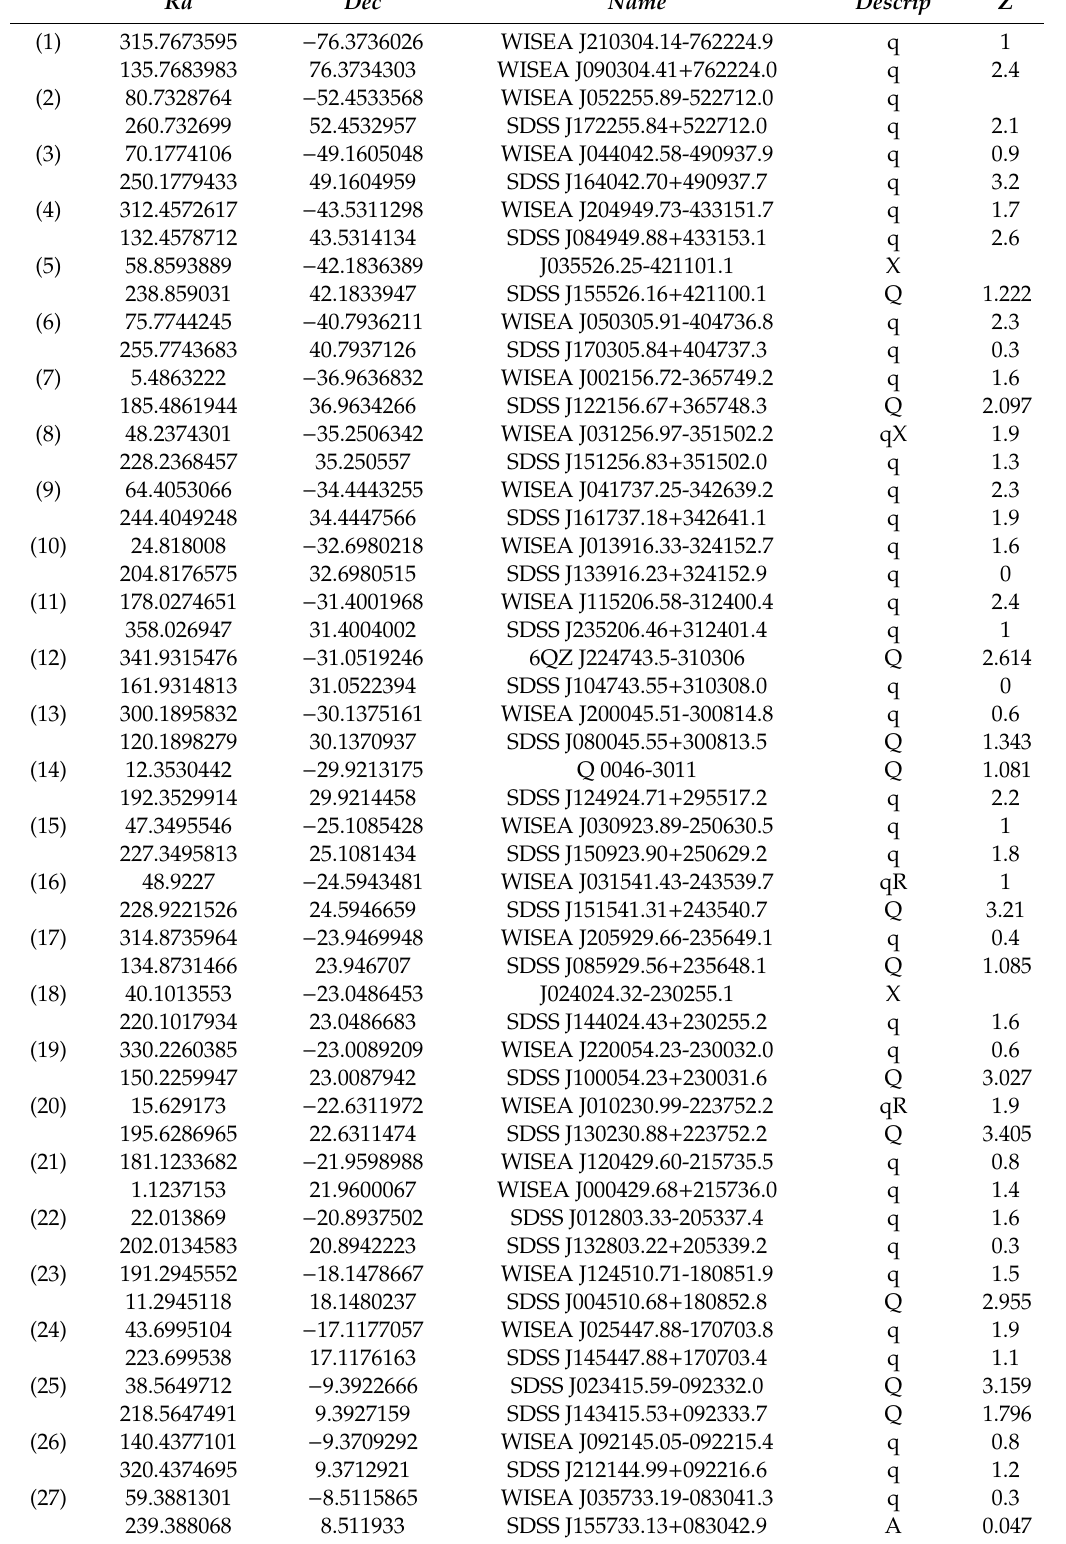
Table A13. Pairs of opposite quasars from the Milliquas 6.3 catalog for the lens e ff ect. Accuracy is of 0.0005 ◦ for ra and dec . Descrip column is the classification of object, see [47]. Redshift z is given when available, although is not essential